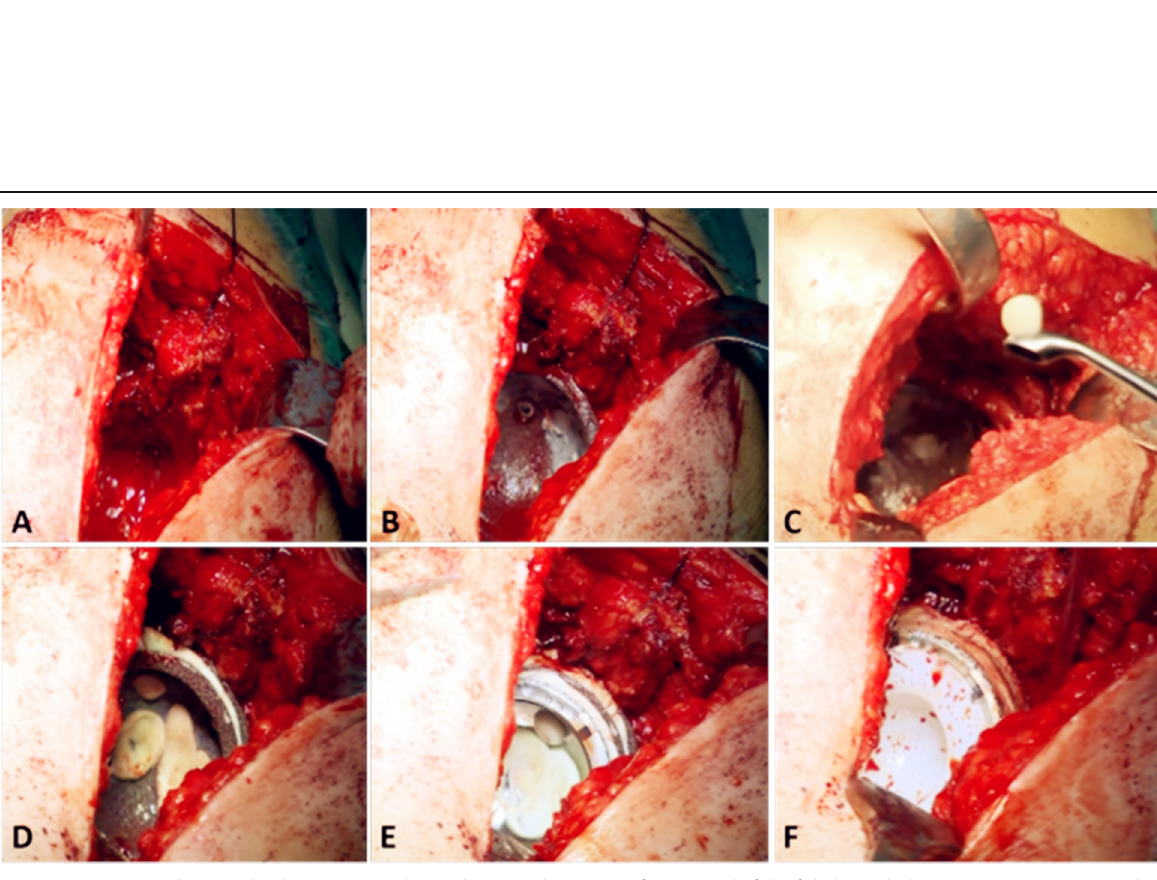
Fig. 4 Intraoperative photographs demonstrating the “ multicup ” technique. A After removal of the failed acetabular components, cement and membrane, the acetabular deficiencies were confirmed again intraoperatively. B The medial TM tantalum revision shell was implanted into the medial defect with multiple screws to serve as upgraded-augment or the foundation for the following porous cups. C The screw holes on the bottom TM cup were blocked with wax to prevent the cement from entering the interface between the host bone and the tantalum revision shell. D The smaller second cup was cemented into the medial shell with the desired anteversion and abduction. E The additional porous cup was added to the finished “ cup-in-cup ” construct. F The modular liner with a 10° elevated rim was